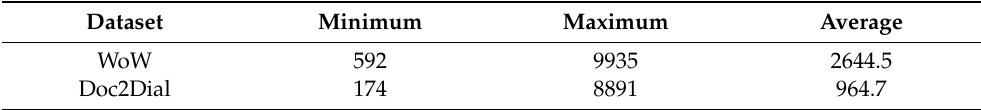
Table 2. Statistics of the document length for both the Wizard-of-Wikipedia dataset and the Doc2dial